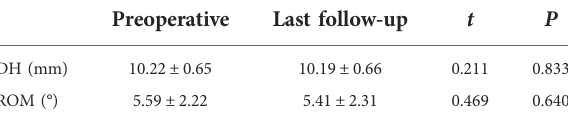
TABLE 4 Comparison of preoperative and postoperative DH and ROM.